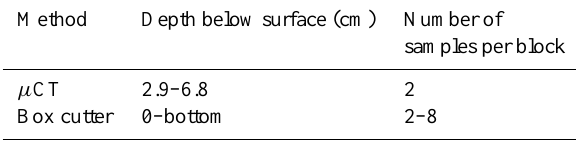
Table 2. Depth below surface and number of measure- ments/samples per block for the instruments used in the lab.